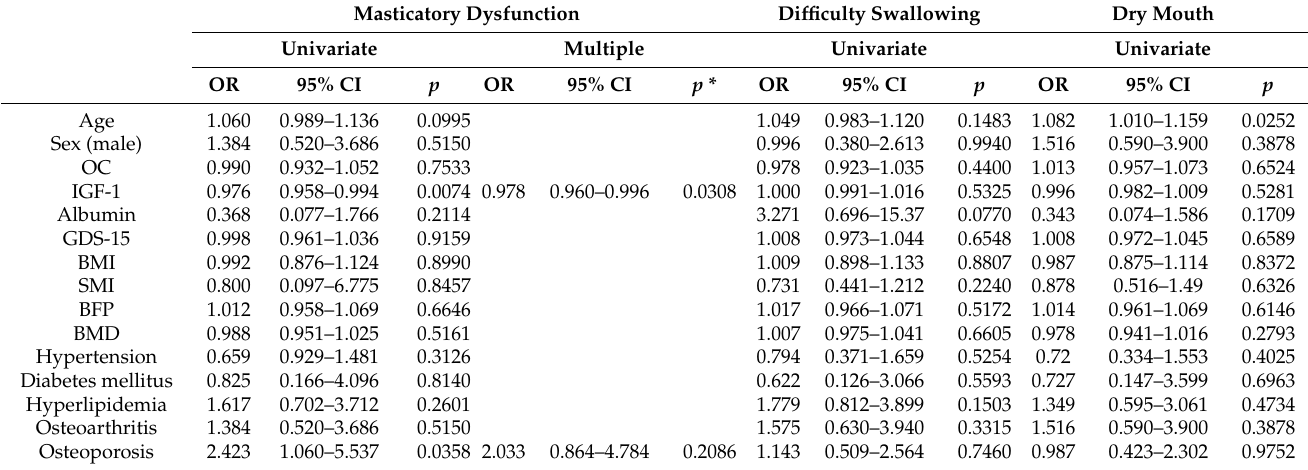
Table 2. Odds ratios of participants’ characteristics for oral dysfunction.